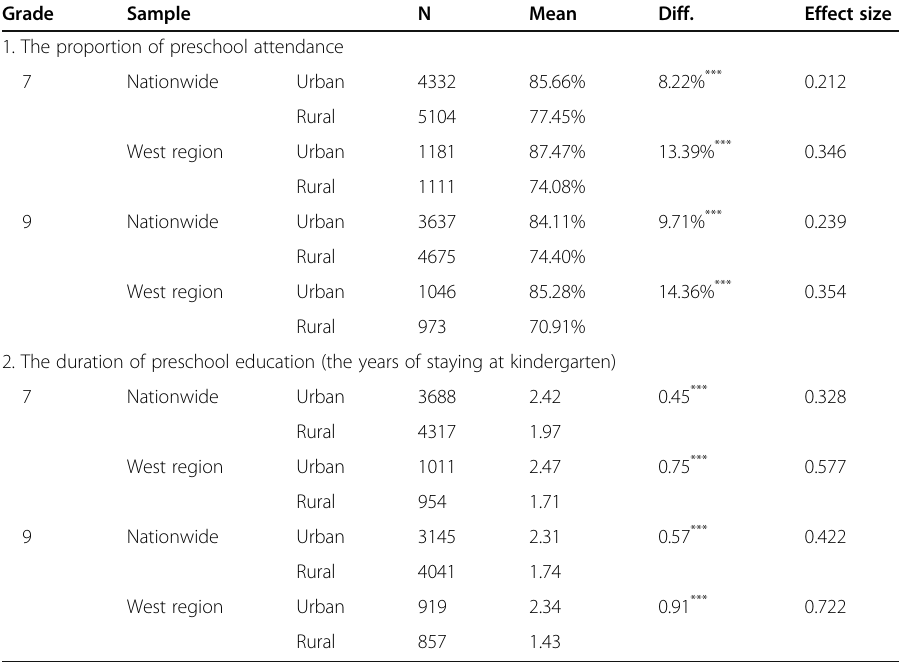
Table 2 Preschool experience of urban and rural students